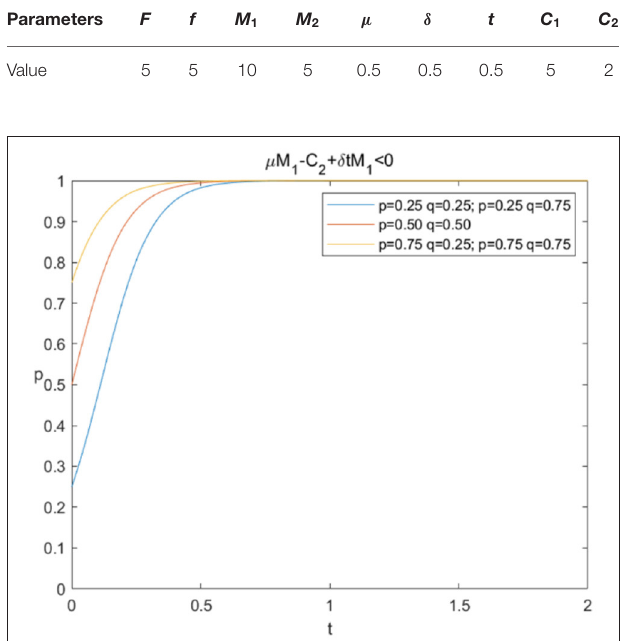
TABLE 4 | Parameter settings of e-commerce platforms.